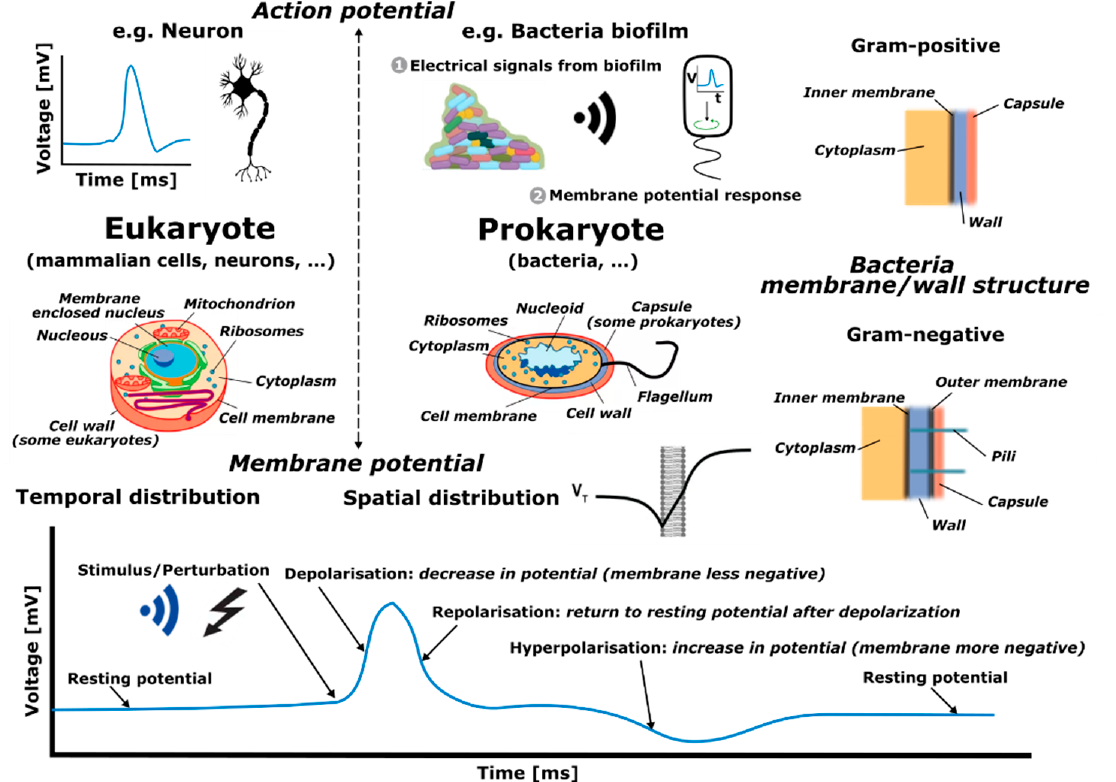
Figure 1. Cells are categorized into eukaryote and prokaryote cells. Additionally, bacteria are categorized according to Gram-negative and Gram-positive, relating to different membrane or wall structure characteristics, as depicted in the upper/middle-right panel. The dynamic process known as an action potential happens in both types of cells. In particular, the membrane potential, given a specific location, changes in time in response to a stimulus or perturbation, as depicted in the bottom graph.